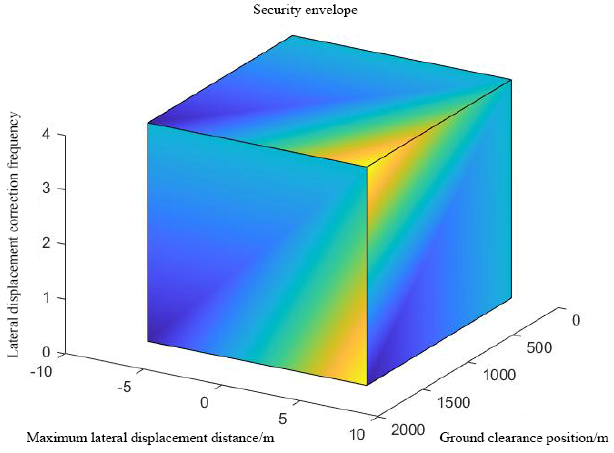
Figure 7. Security envelope.